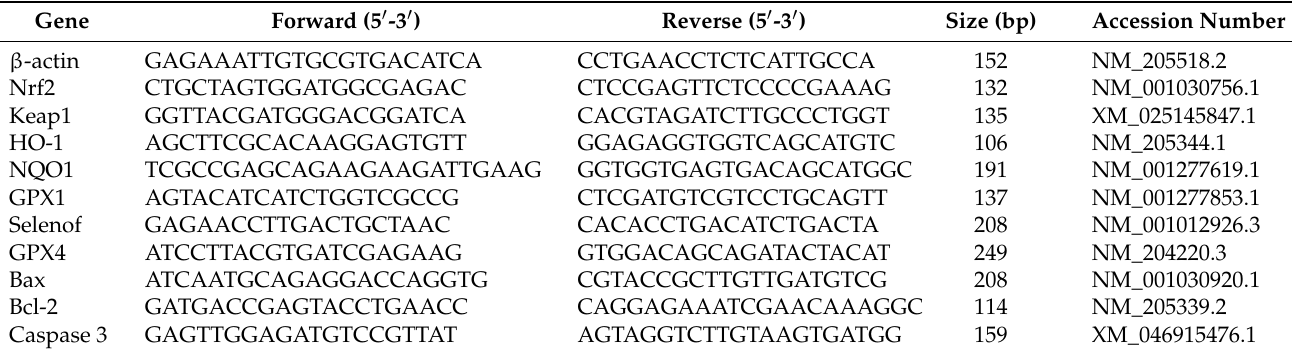
Table 2. Primer sequences used for real-time